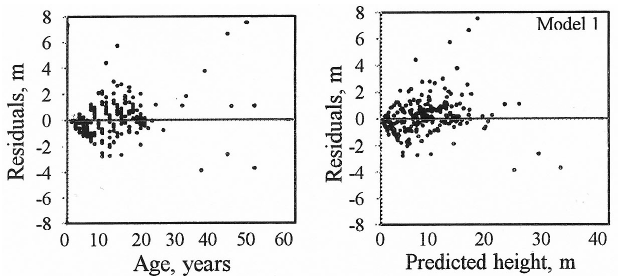
Figure 3. Residuals of the site growth models for hybrid